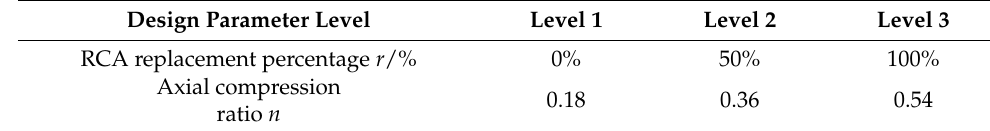
Figure 1. Size and distributed steel of specimens (mm).